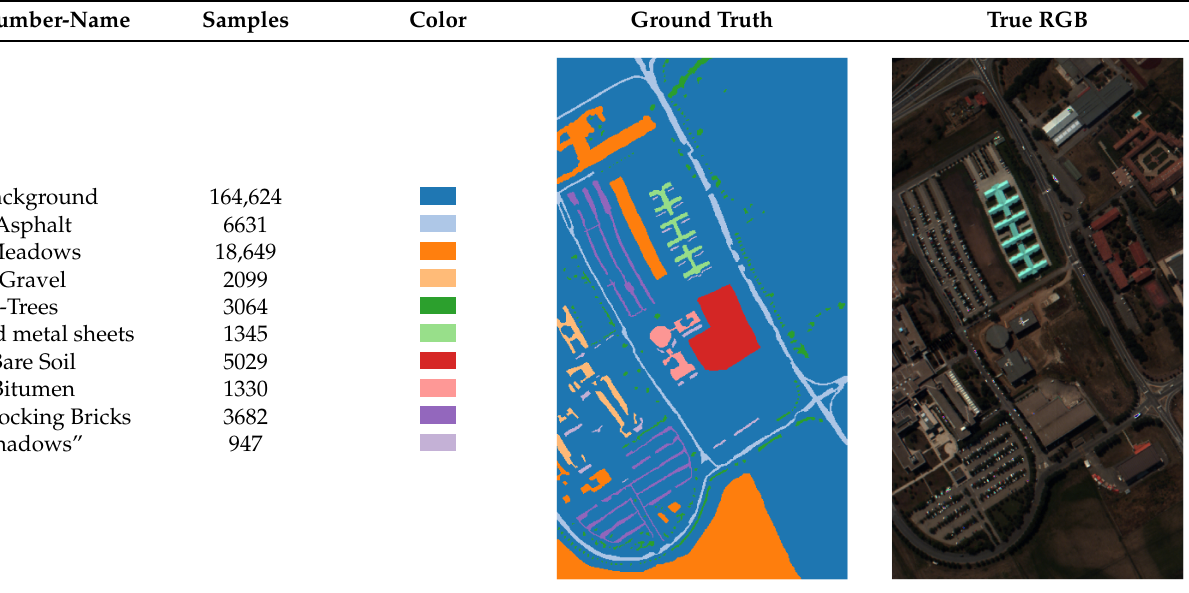
Table 5. University of Pavia ground truth description and true RGB visualization, from [2].